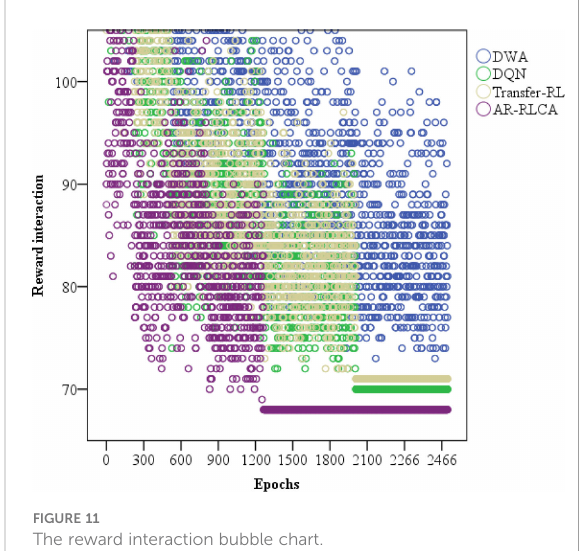
FIGURE 11 The reward interaction bubble